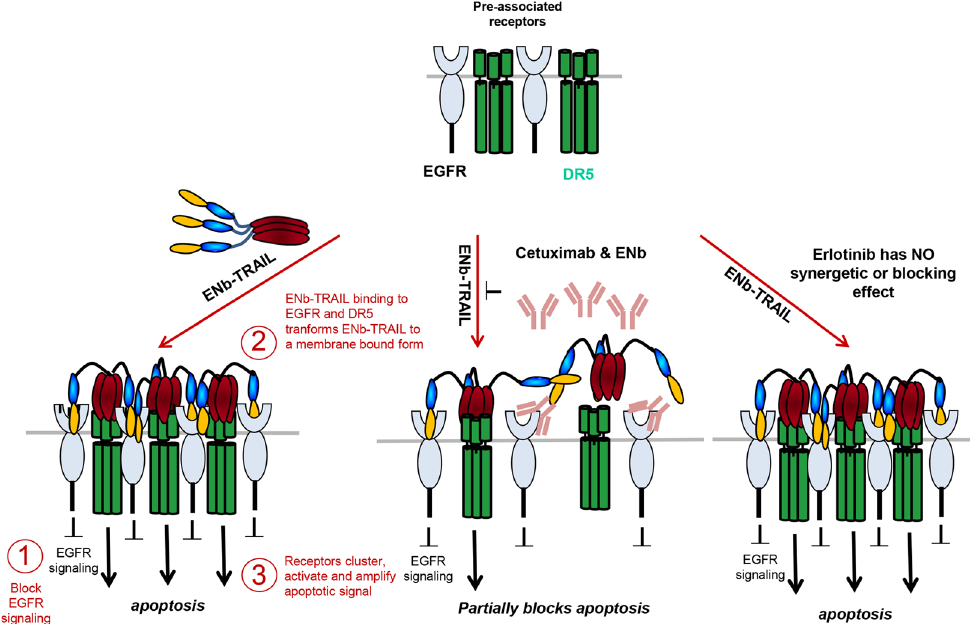
Figure 6. Model of ENb-TRAIL function. EGFR and DR5 are co-engaged at the surface of tumor cells. Trimerized ENb-TRAIL binds simultaneously to EGFR and DR5 leading to receptor clustering and amplification of apoptotic signal. Blocking EGFR with Cetuximab or ENb abolishes ENb-TRAIL binding to EGFR and subsequent activation of apoptosis. EGFR tyrosine kinase inhibitor, Erlotinib inhibits EGFR and AKT activity but does not influence activation of apoptosis by